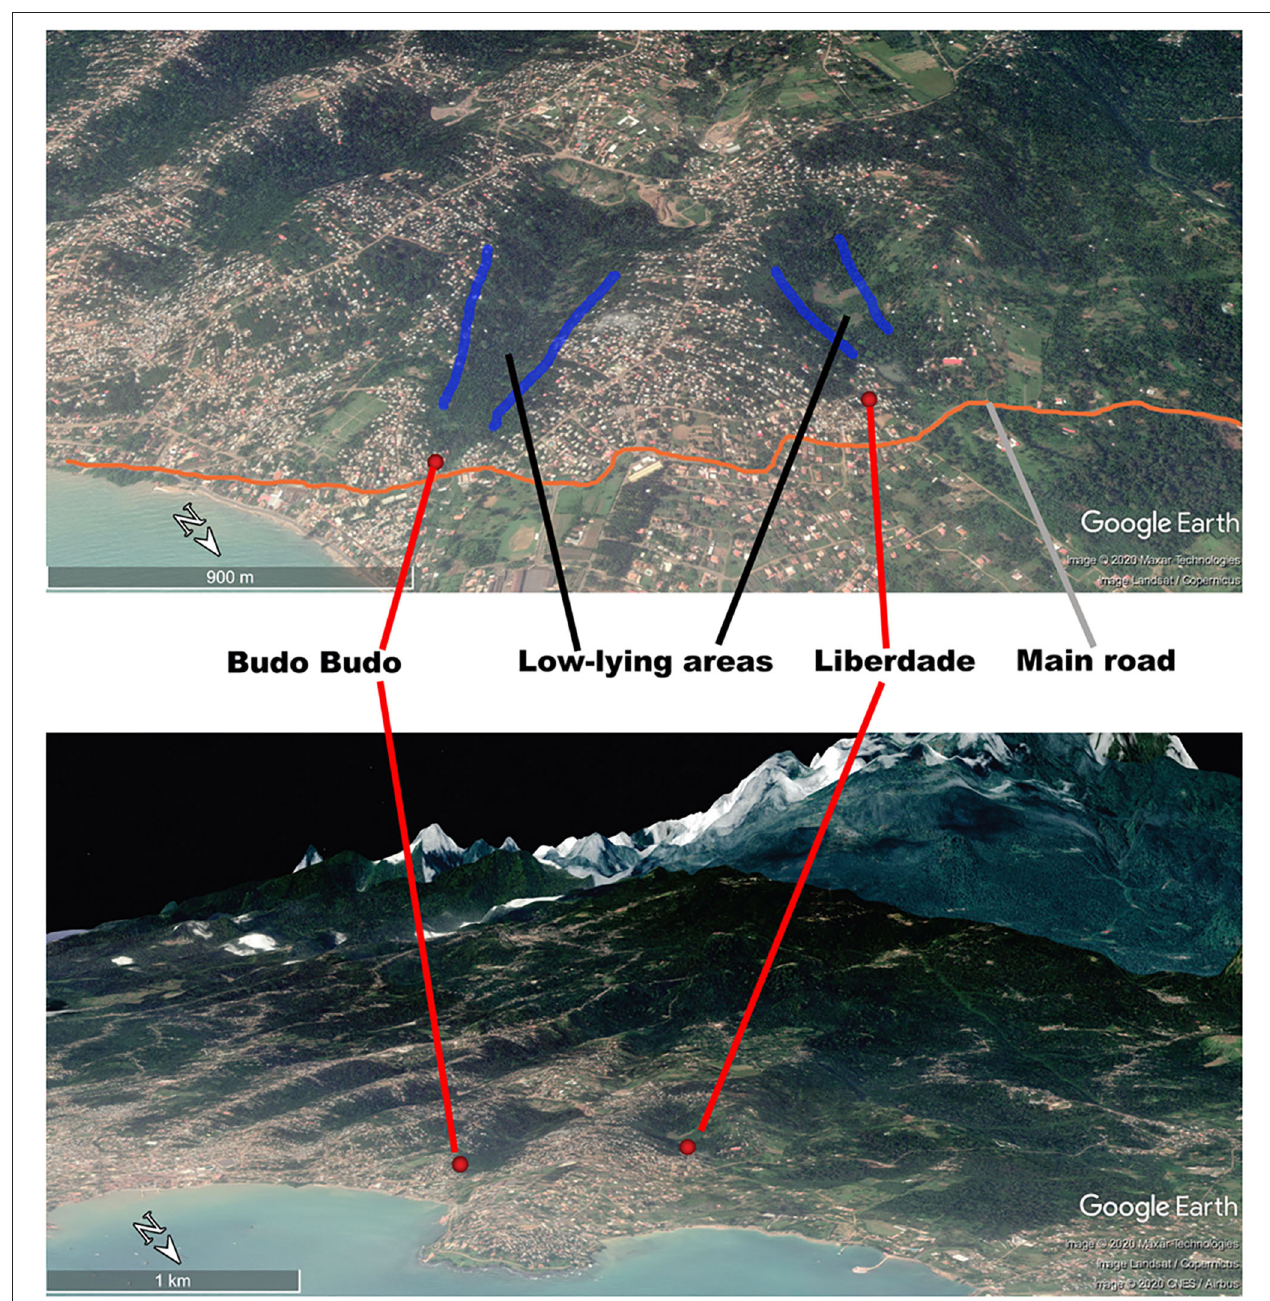
FIGURE 3 | Geographical location of Liberdade and Budo